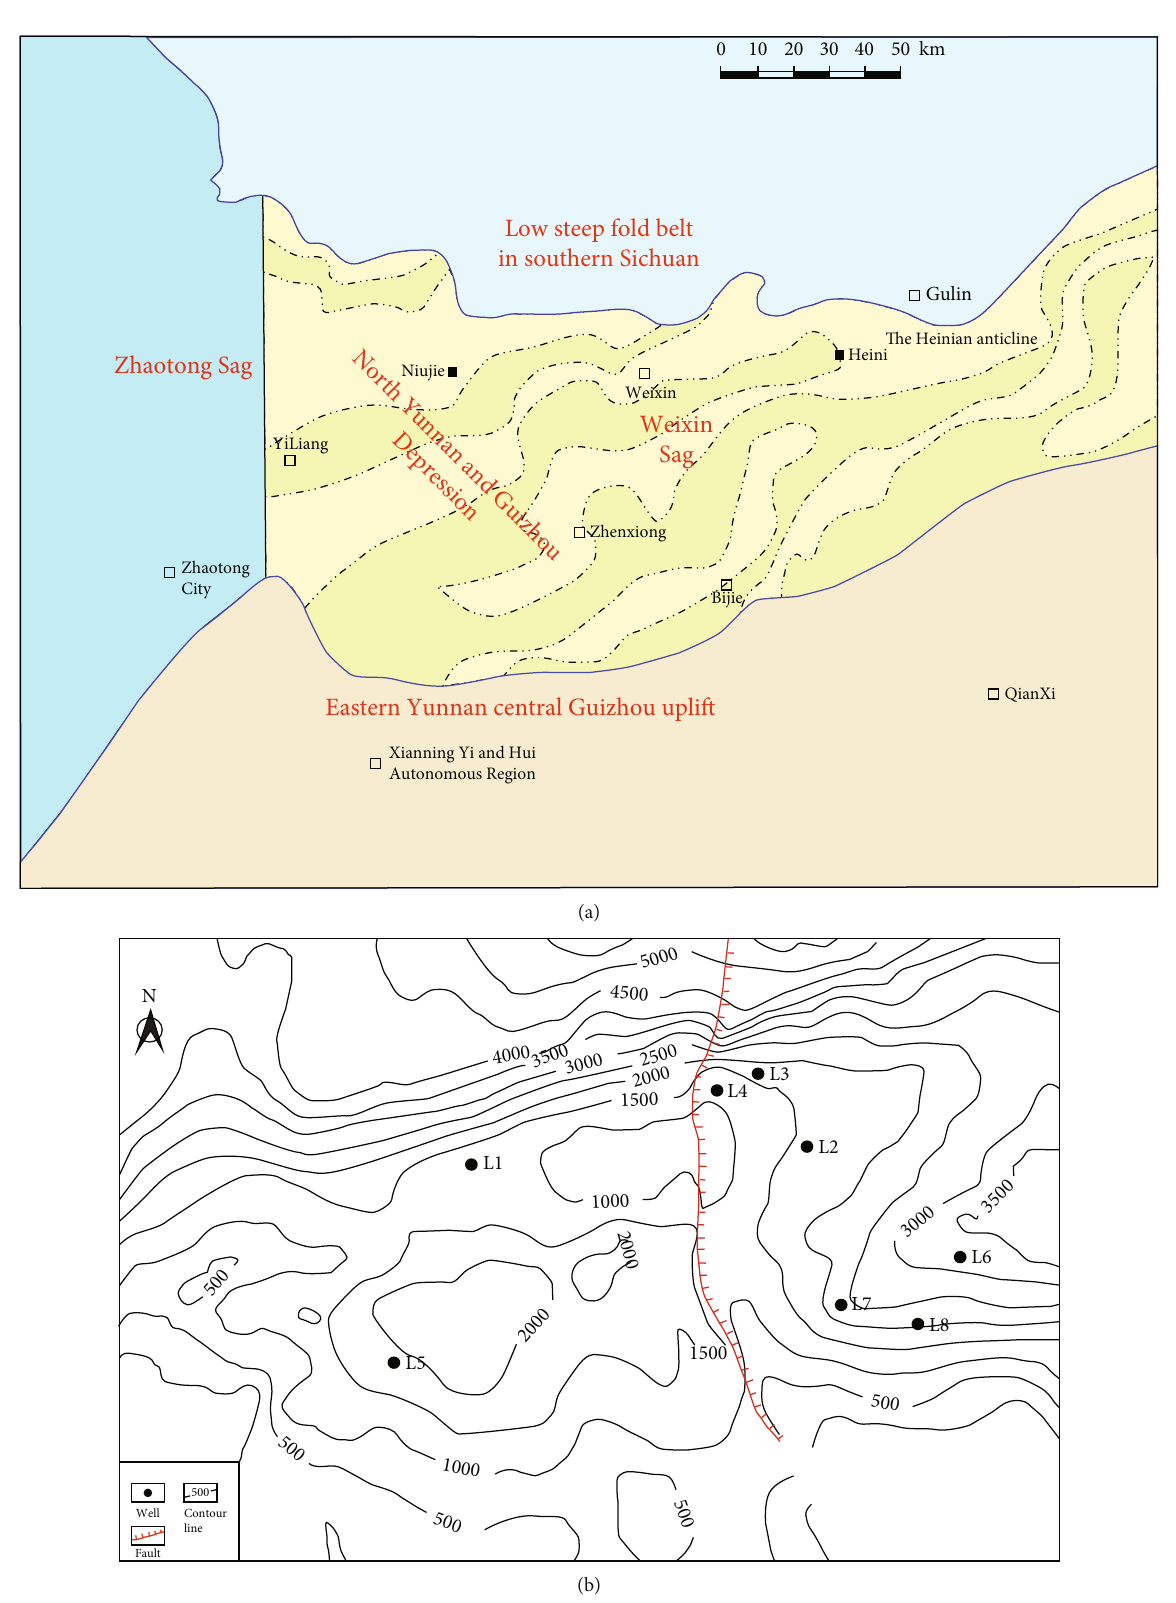
Figure 1: Maps showing the location of the study area. (a) The sketch map showing the Sichuan Basin and its adjacent area. (b) The map showing the wells distribution, contour line, and faults of the study